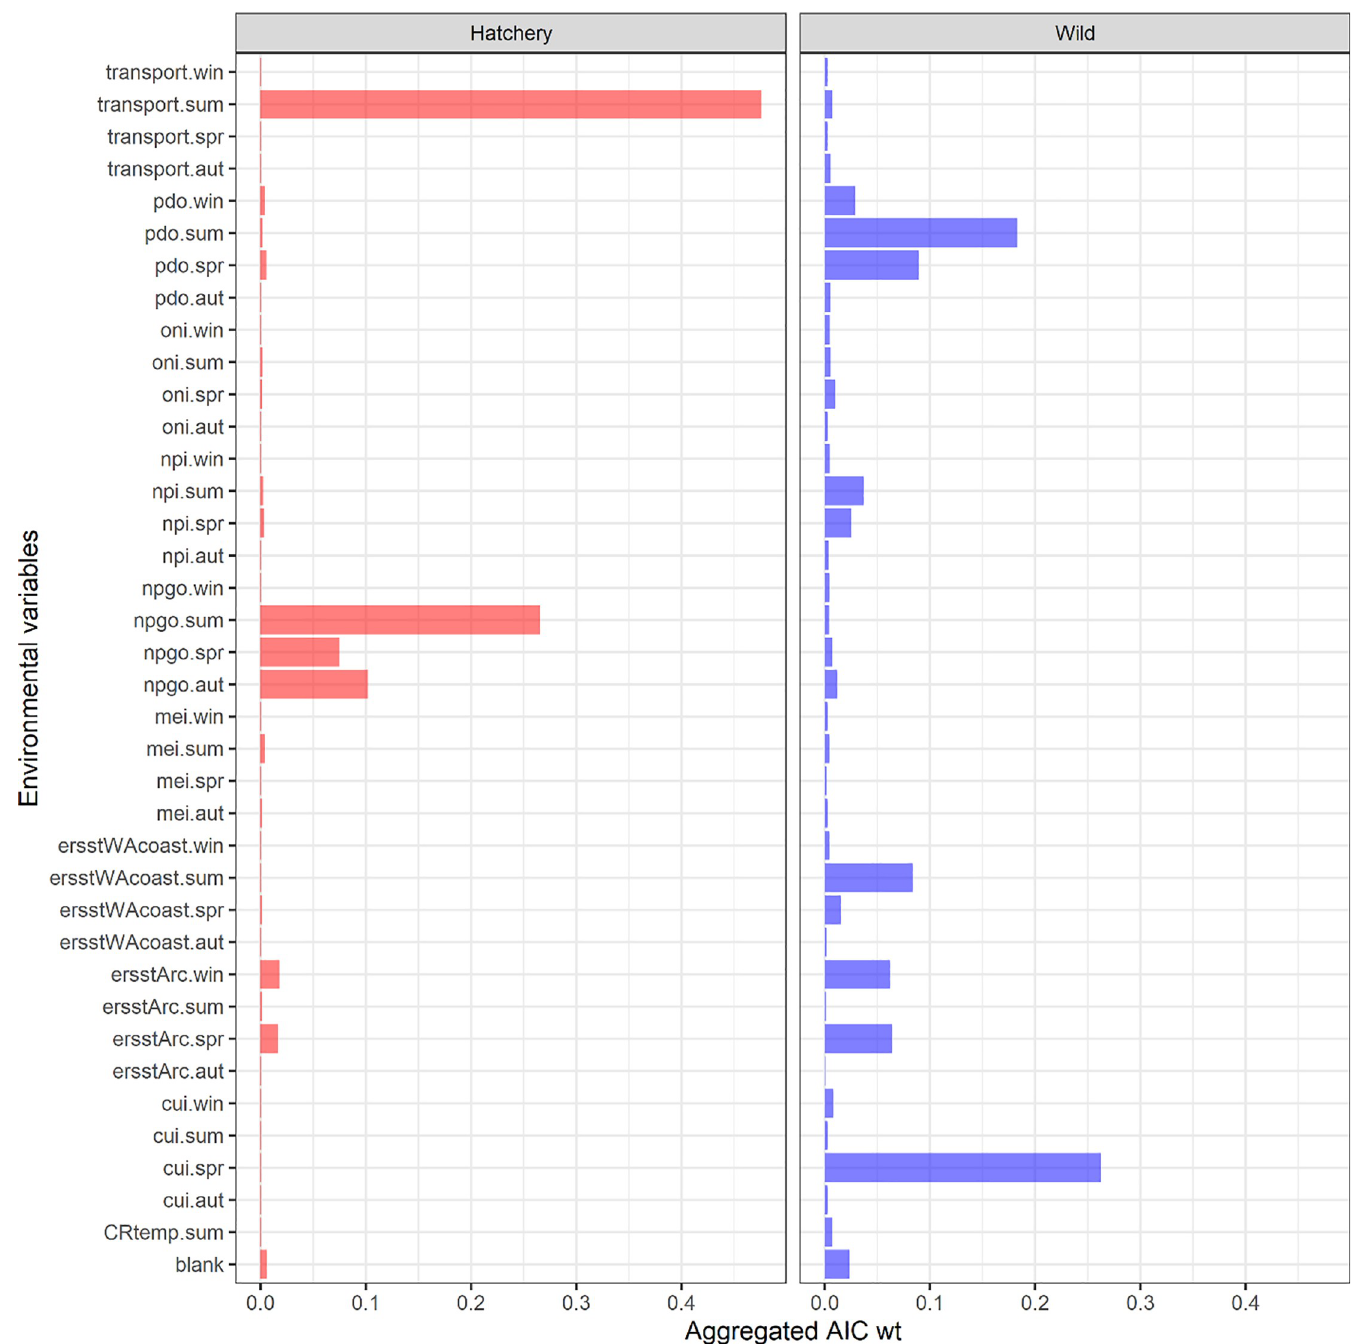
Fig 2. Relative importance of environmental covariates in spring/summer Chinook salmon survival models. Relative importance of the different marine covariates for predicting the marine survival of hatchery (left column) and wild (right column) spring/summer Chinook salmon, where the aggregated weight of a covariate c is equal to the sum of the AIC weights for all m models containing covariate c , divided by the total weight across all m models variable is for models with no environmental predictors.